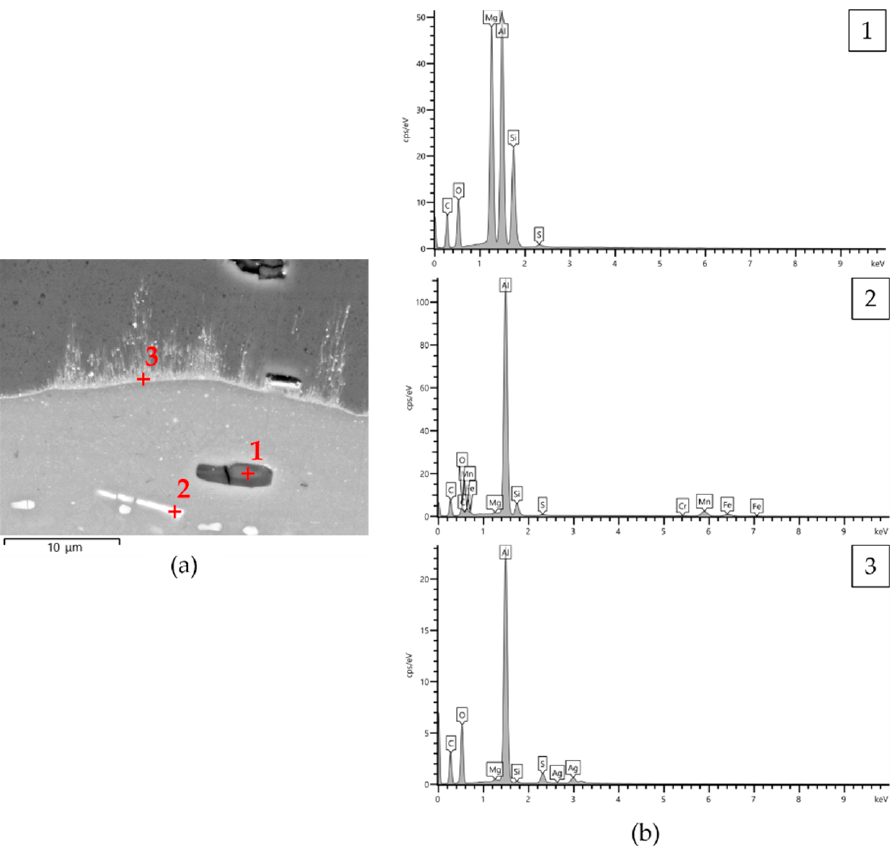
Figure 2. ( a ) VPSEM micrograph in back-scattered electron mode of microstructure observed on the cross-section of GP_25 pins before wear tests and ( b ) semi-quantitative EDS analyses (wt %) of different areas in the same microstructure.